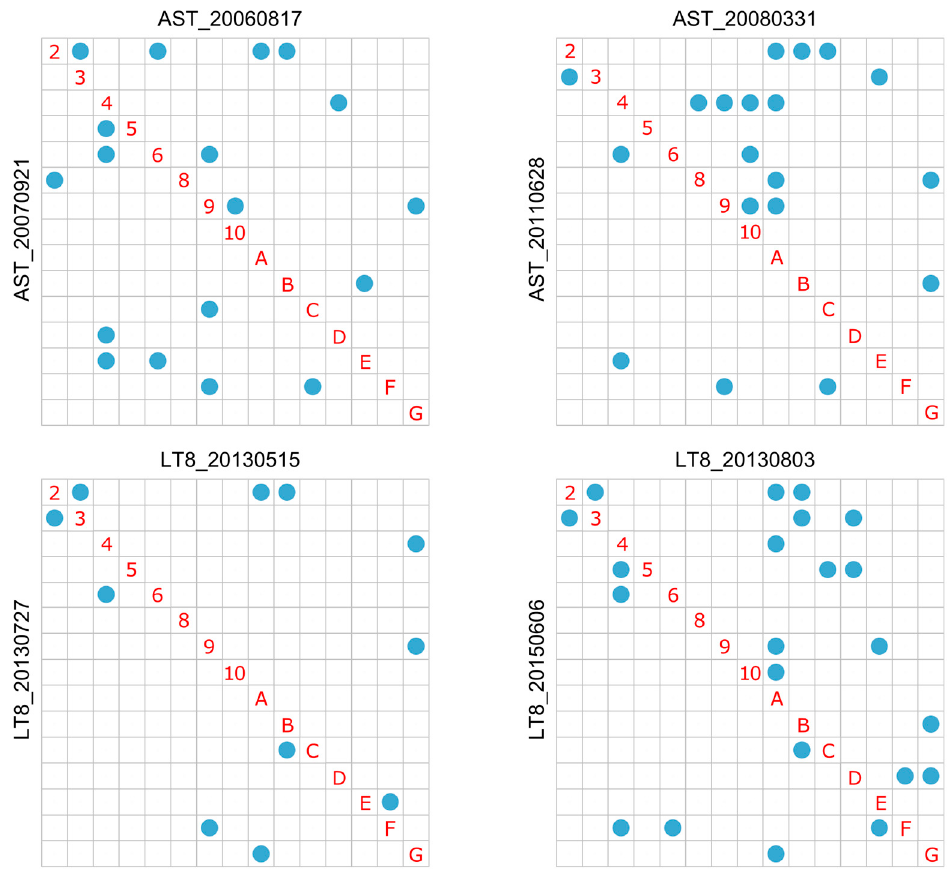
Figure 10. Results of the Tukey-HSD test for all combinations of LCZ classes (red numbers and letters) and for all analyzed scenes in Prague; see Table 3 for the scene ID; blue points indicate pairs of LCZs for which land surface temperatures are not significantly different ( p > 0.05), while empty cells denote LCZs pairs for which their average LSTs are significantly different.